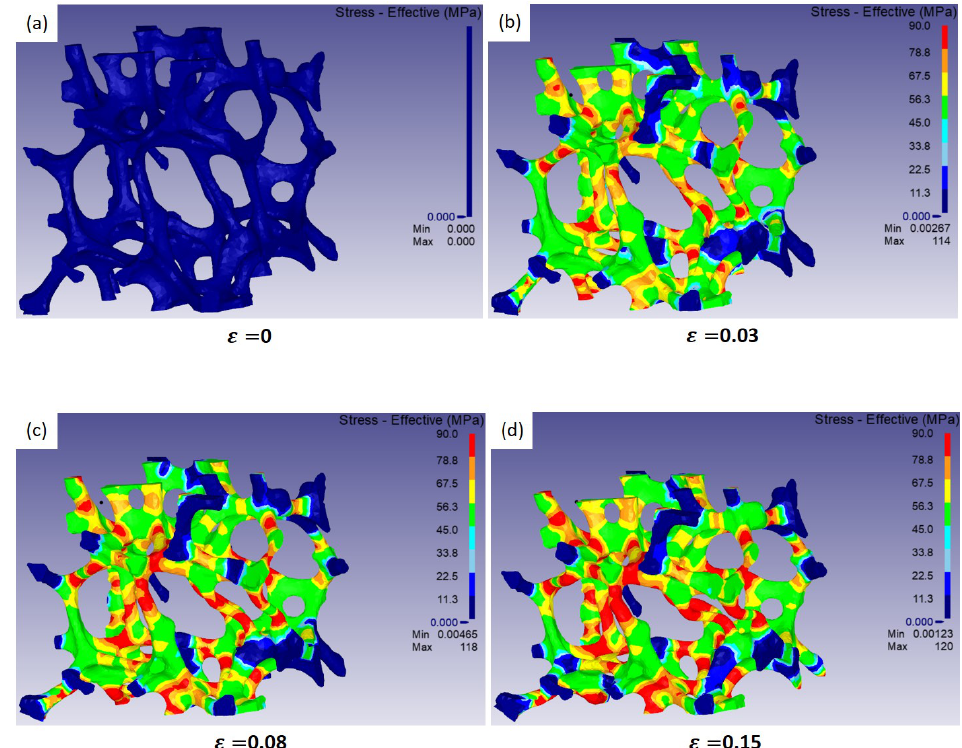
Figure 11. Predicted microstructural evolution of the selected model domain of interest with strain.